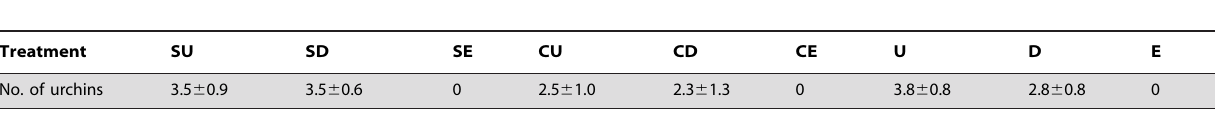
Treatment No. of urchins